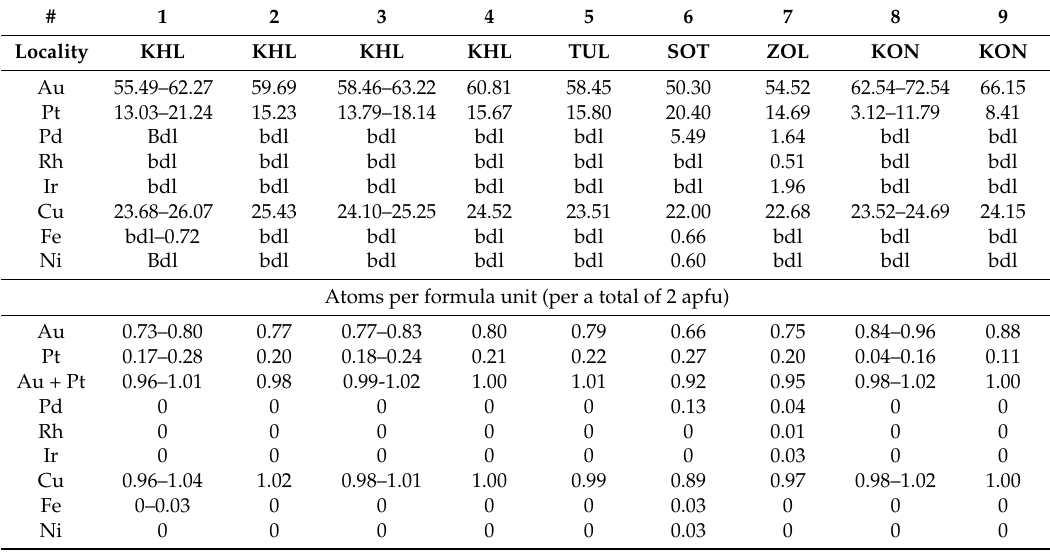
Table 1. Compositions of platiniferous tetra-auricupride from Bolshoy Khailyk and other